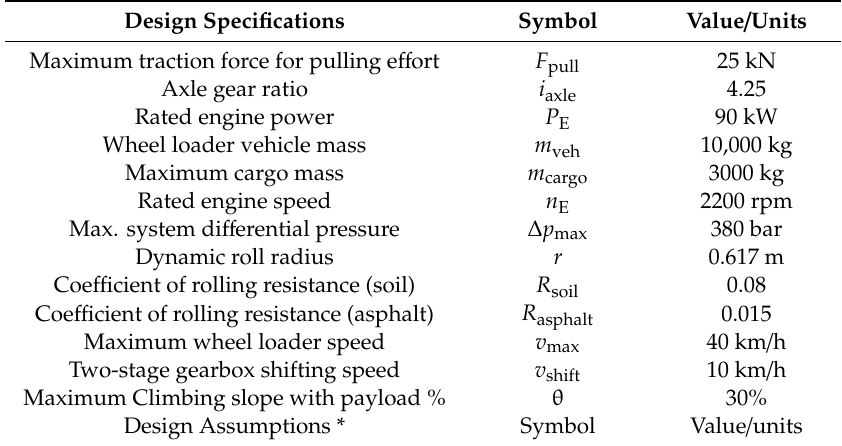
Table 1 lists the all design specifications and assumptions for wheel loader powertrain design. Table 1. Wheel loader design specifications and assumptions Table 1. Wheel loader design specifications and assumptions [14]. Table 1. Wheel loader design specifications and assumptions [14].